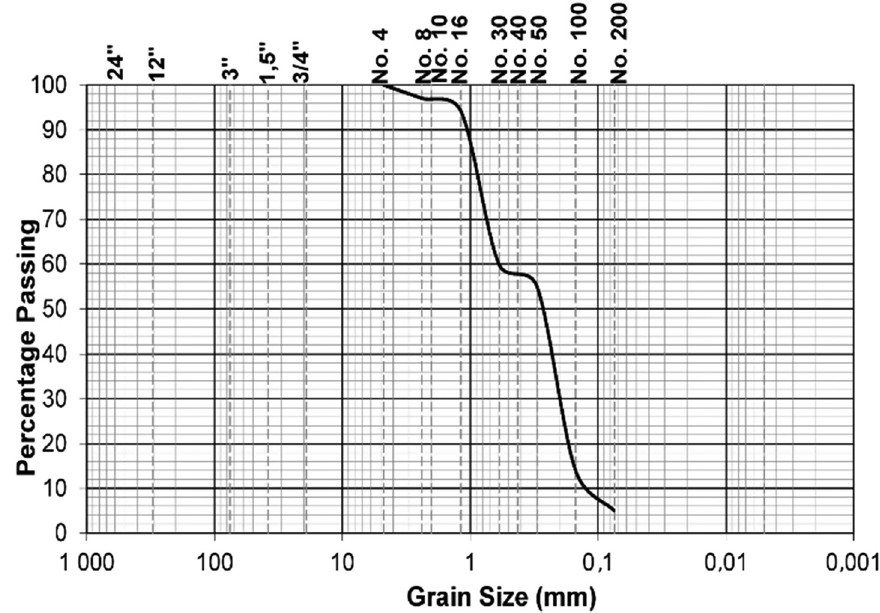
Figure 2: Sand gradation curve.